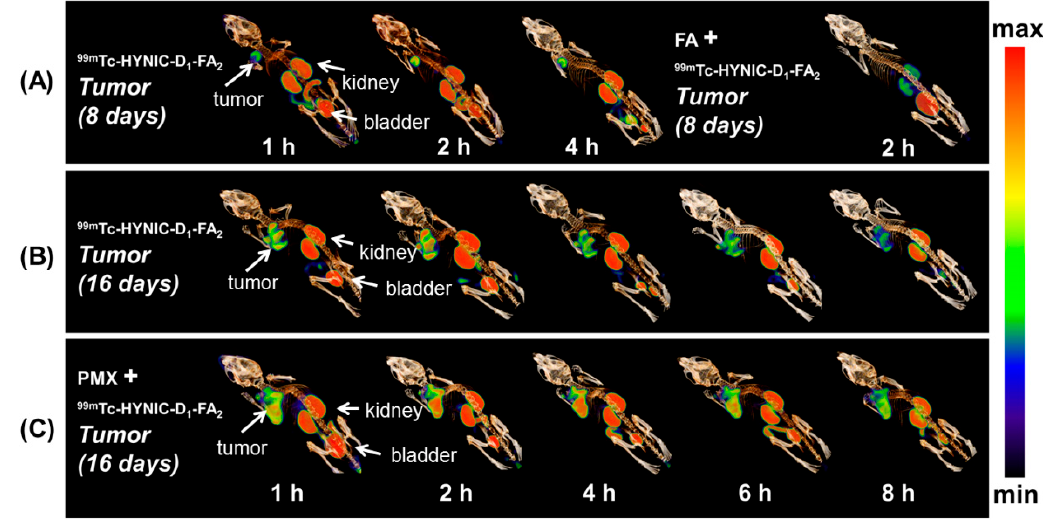
Figure 2. SPECT/CT imaging of xenografted KB-tumor in athymic nude mice. ( A ) 8-days tumor-bearing mice was received 99m Tc-HYNIC-D 1 -FA 2 . Blocking study was performed by giving 100 µg FA at 10 min prior to the injection of 99m Tc-HYNIC-D 1 -FA 2 ; ( B ) 16-days tumor-bearing mice was received 99m Tc-HYNIC-D 1 -FA 2 ; ( C ) 16-days tumor-bearing mice was received 400 µg PMX at 1 h prior to the injection of 99m Tc-HYNIC-D 1 -FA 2 .